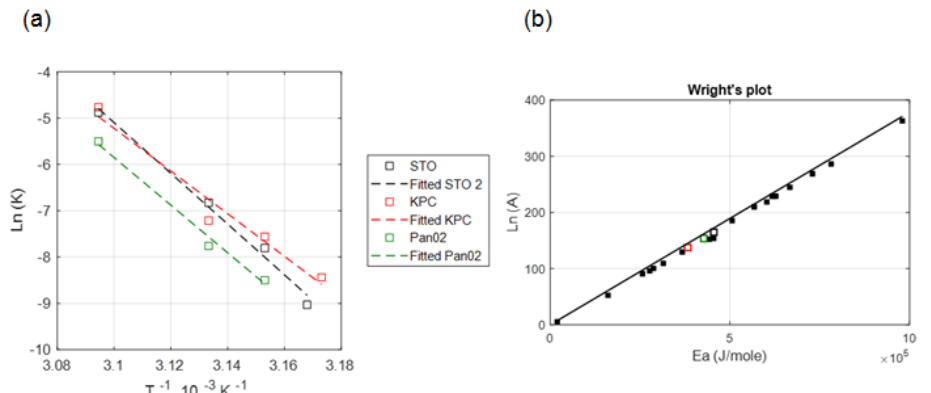
Figure 4. ( a ) Correlation between the kinetic coefficients, ln (A) and E a (KPC + Pan02 + STO), ( b ) comparison between the Wright’s plot (relationship between Arrhenius coefficients based on the literature) shown in solid black square markers and obtained Arrhenius coefficients for three different cell lines in our study. Hollow black, red and green square markers indicate the obtained Arrhenius coefficients for STO, KPC and Pan02 cells, respectively at 24 h post treatment in our study. Table 2. Obtained Arrhenius coefficients for all three cell lines.